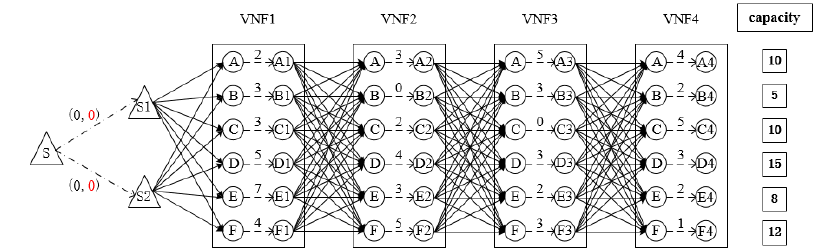
Figure 6. SFC (service function chain) embedding in the MOD (multilevel overlay directed) network.